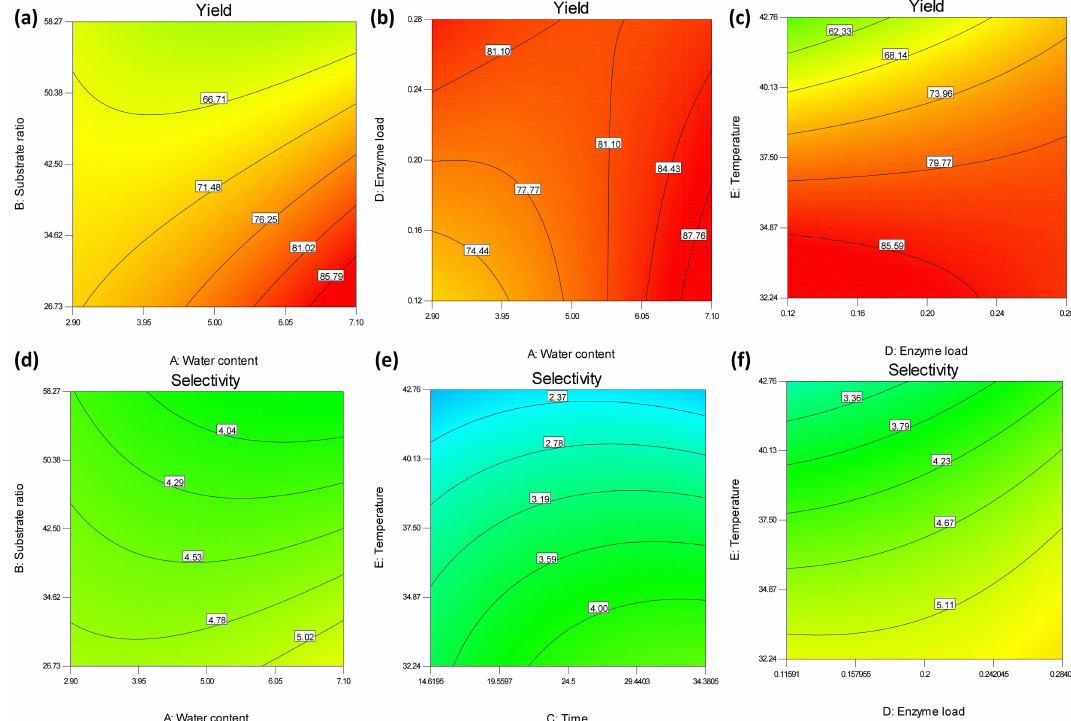
Figure 6. Contour plots for the yield ( a – c ) and selectivity ( d – f ) of prenyl ferulate synthesis from FAE125 in octane. ( a , d ) interaction between substrate ratio and water content, ( b ) interaction between enzyme load and water content, ( d , f ) interaction between enzyme load and temperature, ( e ) interaction between temperature and time. In each diagram, all other factors were set to optimum